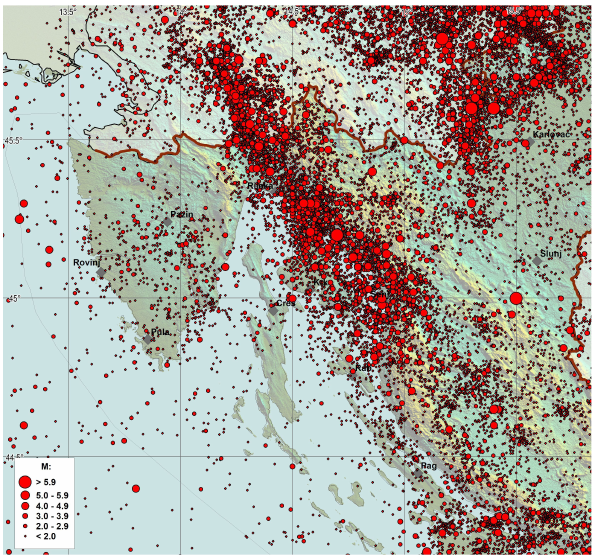
Figure 1. Spatial distribution of earthquake locations in the inves- tigated area (373BCE–2017CE; according to the “Croatian Earth- quake Catalog” – CEC; updated version first described in Herak et al., 1996). When preparing figure, Copernicus land dataset was used (© European Union, Copernicus Land Monitoring Service 2017, European Environment Agency – EEA).